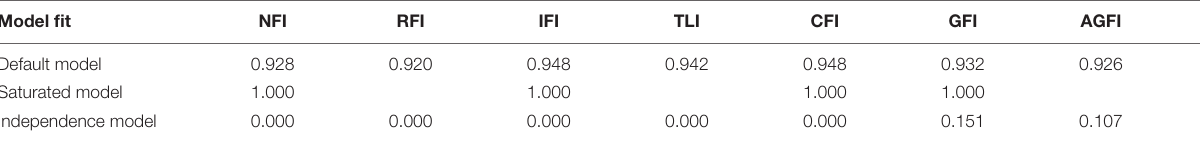
TABLE 3 | Model fit evaluation.